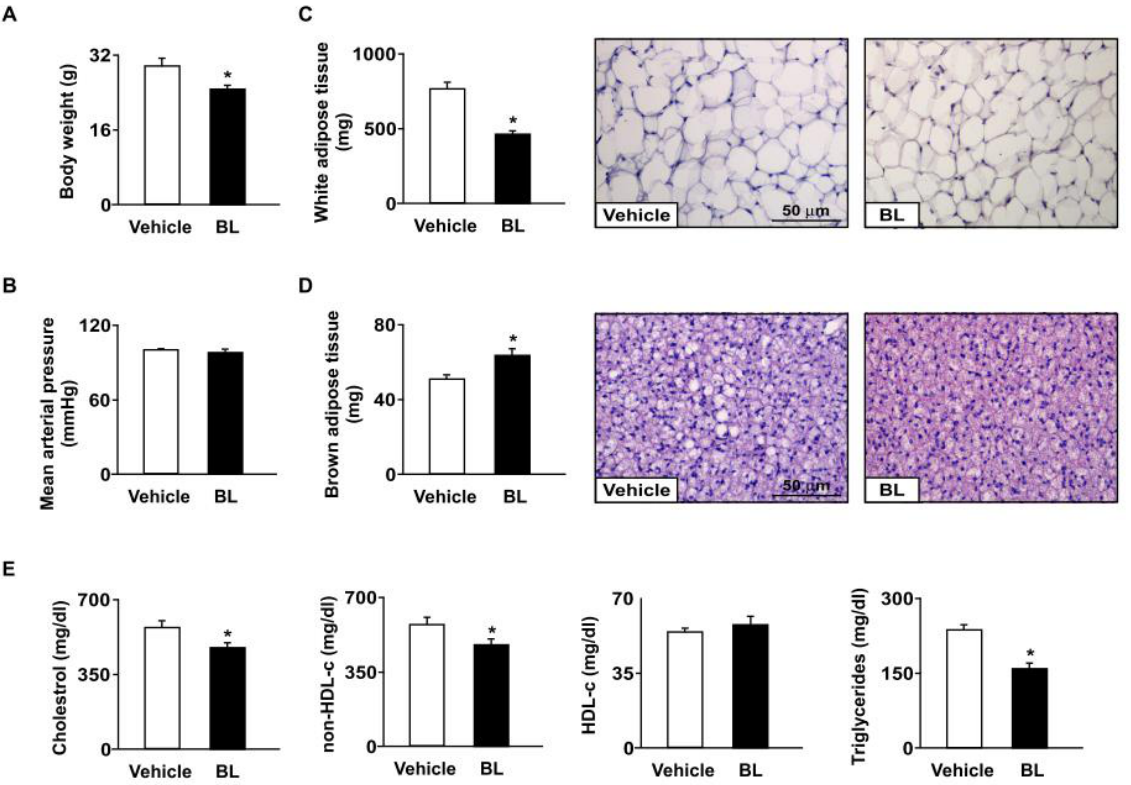
Figure 1. Effects of bromelain on body weight, blood pressure, adiposity, and hyperlipidemia in apoe − / − mice. Male apoe − / − mice were orally administered bromelain (BL, 20 mg/kg/day) or vehicle (PBS) for four weeks. ( A ) Body weight. ( B ) Mean arterial pressure. ( C , D ) The weight and histology of white adipose tissue and brown adipose tissue. Scale bar = 50 µ m. ( E ) Plasma levels of total cholesterol, non-high-density lipoprotein cholesterol (non-HDL-c), HDL cholesterol (HDL-c), and triglycerides. * p < 0.05 vs. vehicle-treated apoe − / − mice.